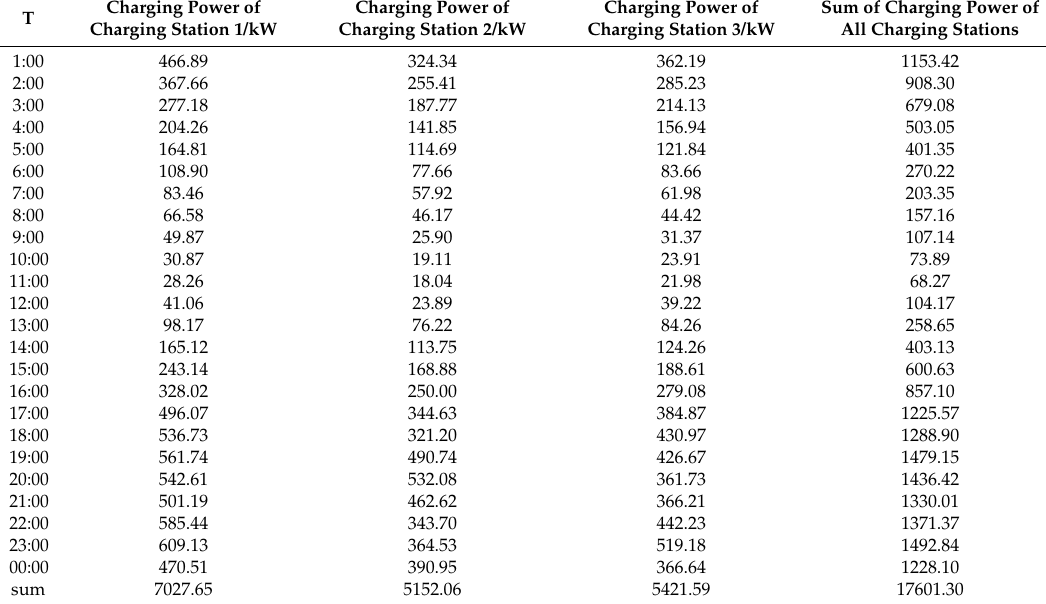
Table A2. Charging power of each charging station at different periods after adjustment for charging